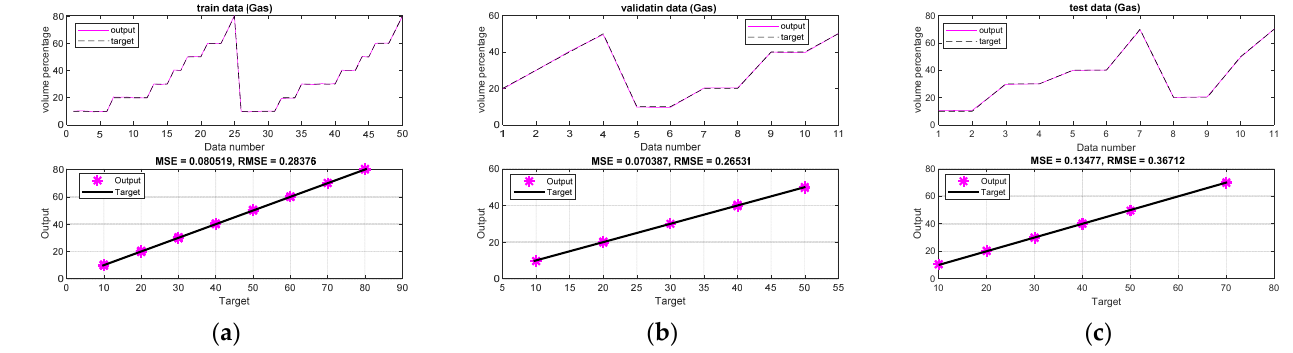
Figure 10. Regression diagram related to the prediction of gas volume percentage for ( a ) training, ( b ) validation, and ( c ) test data. Table 1. A comparison of the suggested detection system’s precision with earlier research.